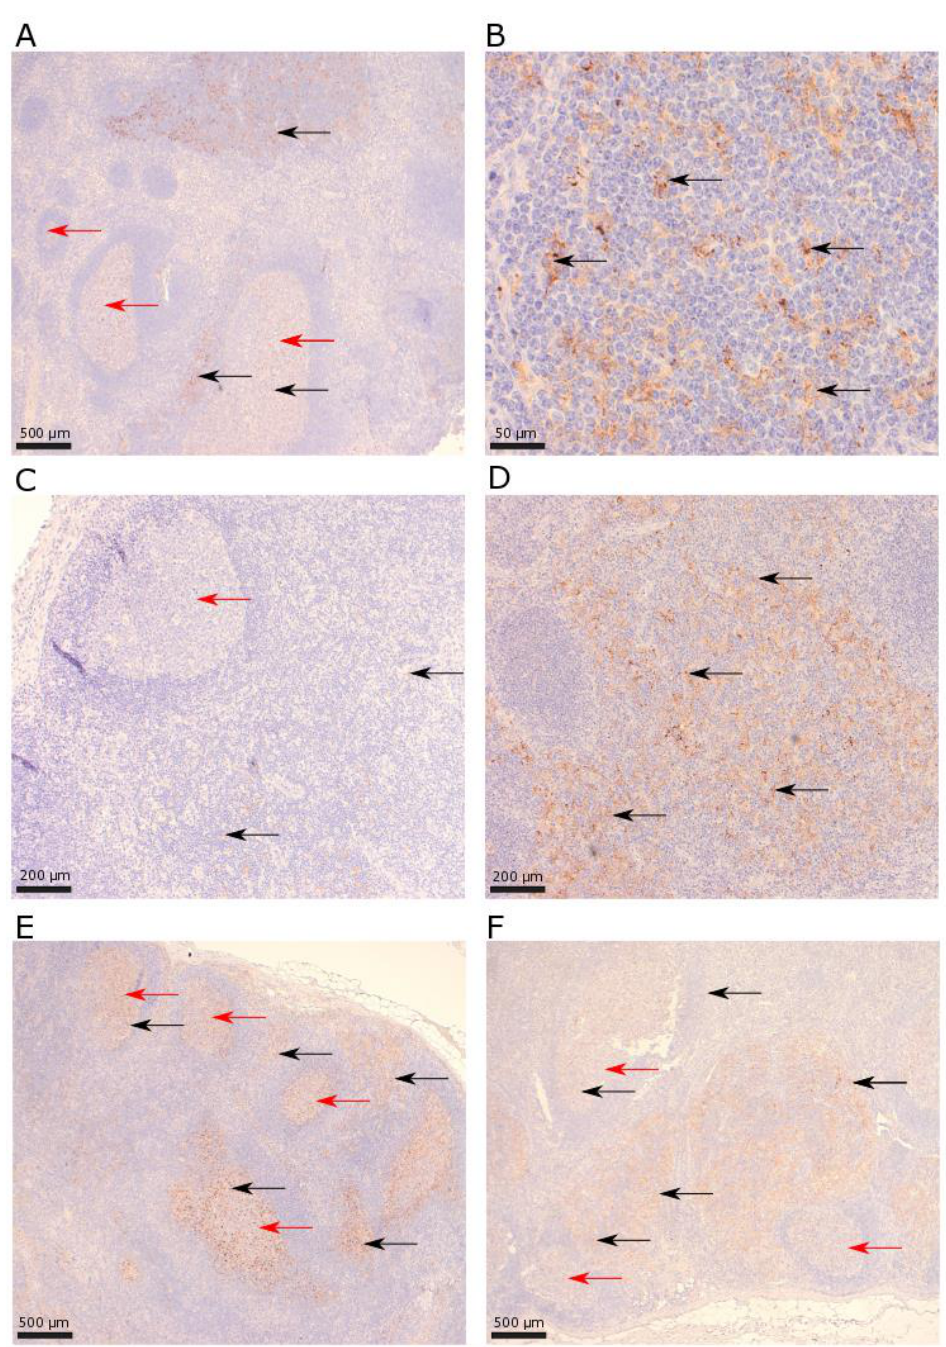
Figure 3. PD-L2 in benign lymphadenopathies (rabbit monoclonal antibody D7U8C/82723 (Cell Signaling Technologies, Danvers, MA, USA)) from patients with autoimmune diseases ( A , B ) and without autoimmune diseases ( C – F ). ( A , B ) Lymph node with high amounts of PD-L2+ cells in both follicular (10%) and interfollicular (14%) areas (magnification 40 × and 400 × , respectively). ( C ) Low amount of follicular (2%) and interfollicular (2%) PD-L2+ cells (magnification 100 × ). ( D ) Intermediate amount of follicular (5%) and very high amount of interfollicular (25%) PD-L2+ cells (magnification 100 × ). ( E ) Very high amount of follicular (20%) and high amount of interfollicular (10%) PD-L2+ cells (magnification 40 × ). ( F ) Intermediate amount of follicular (5%) and very high amount of interfollicular (30%) PD-L2+ cells (magnification 40 × ). PD-L2+ leukocytes = black arrow, follicular areas = red